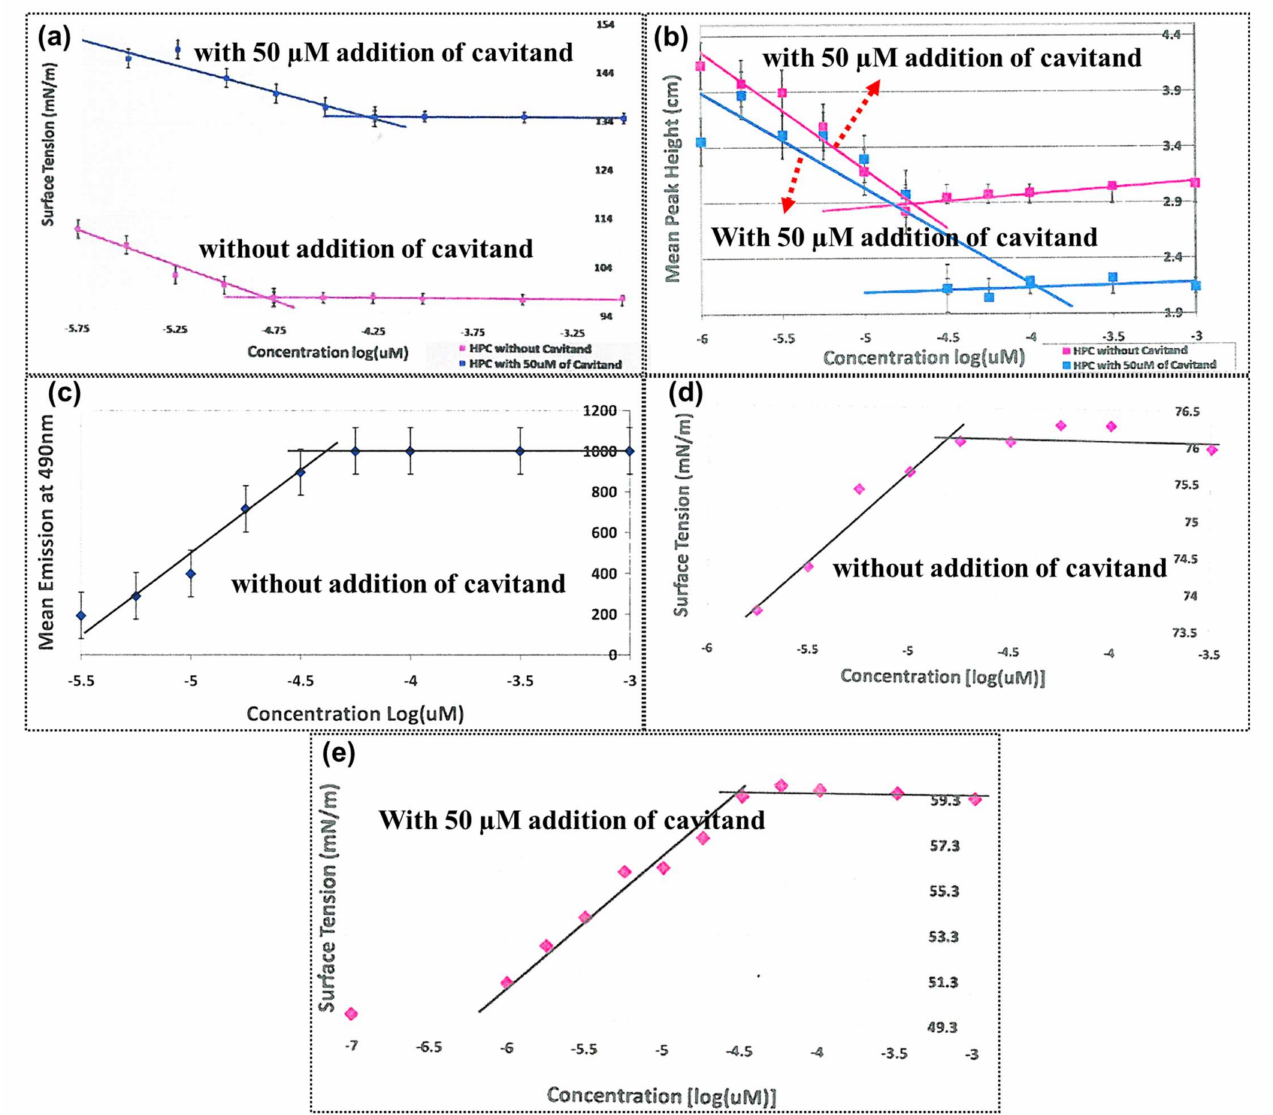
Figure 1. CMC determination of HePC with 50 µ M of cavitand and without cavitand via the filter paper method ( a ), the capillary height method ( b ), the dye micellization method ( c ), and the Wilhelmy plate method ( d , e ). Reprinted from ref.